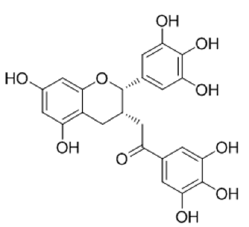
Figure 33. Structure of kavalactones and glucosylsterols isolated from the rhizome extract of Piper methysticum . Figure 34. Structure of ( − )-cubebin. Figure 35. A proposed scheme showing the activation mechanism of cubebin on melanogenesis [107]. In 2008, Faas et al. [108] investigated the ability of PIP and three analogues (THP, CHP and rCHP, Figure 36) to stimulate pigmentation in a strain of sparsely pigmented mice. The results showed that treatment with PIP, THP or rCHP and UVR induced a marked pigmentation response in HRA/Skh-II mice, with clinically better results than UVR alone, which supported the potential use of these compounds in treating vitiligo.